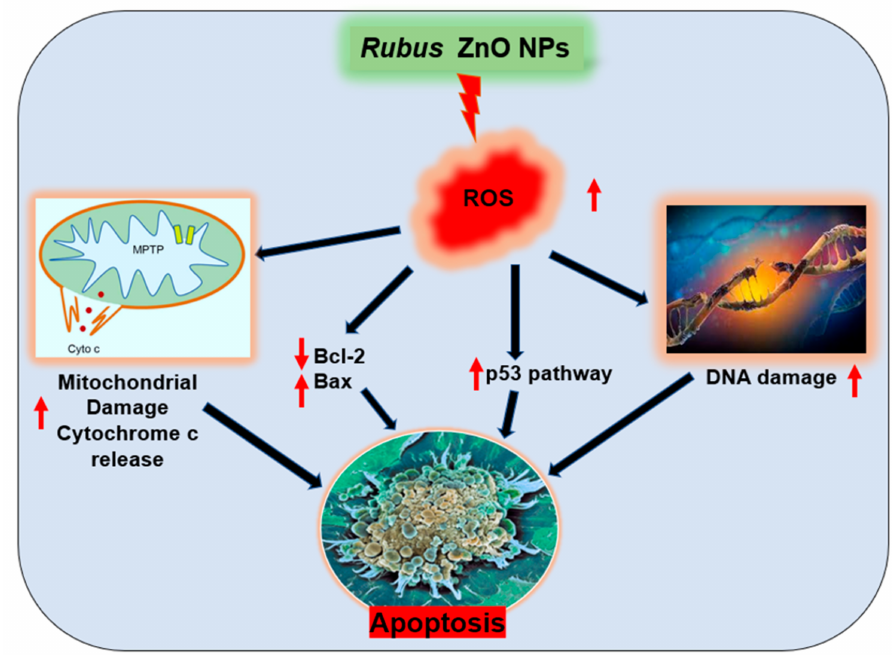
Figure 7. Proposed cell death mechanism induced by Rubus fairholmianus capped zinc oxide nanopar- ticles (RFZnO NPs). The reactive oxygen species (ROS) produced during RFZnO NP treatment induced mitochondrial cytochrome c release, induced nuclear damage, and increased the activity of p53 and Bax while reducing the activity of Bcl-2, leading to apoptotic cell death in breast cancer